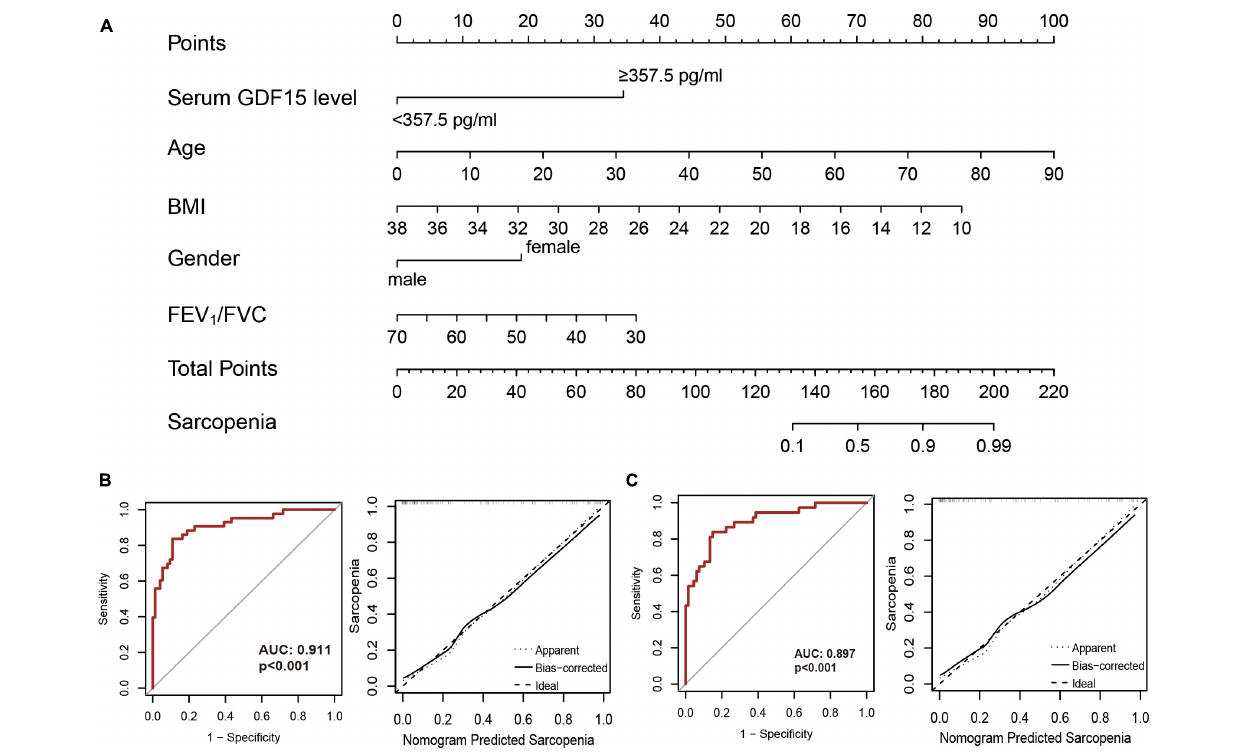
FIGURE 4 | Construction of nomogram models. (A) A nomogram combining serum GDF15 level and clinical features was constructed based on the development set; (B) receiver operating characteristic curve analysis (left) and decision curve analysis (right) in the development set; (C) receiver operating characteristic curve analysis (left) and decision curve analysis (right) in the validation